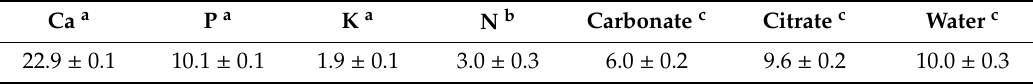
Table 1. Chemical composition, wt %, of U-ACP nanoparticles. Data are expressed as mean ± standard deviation.